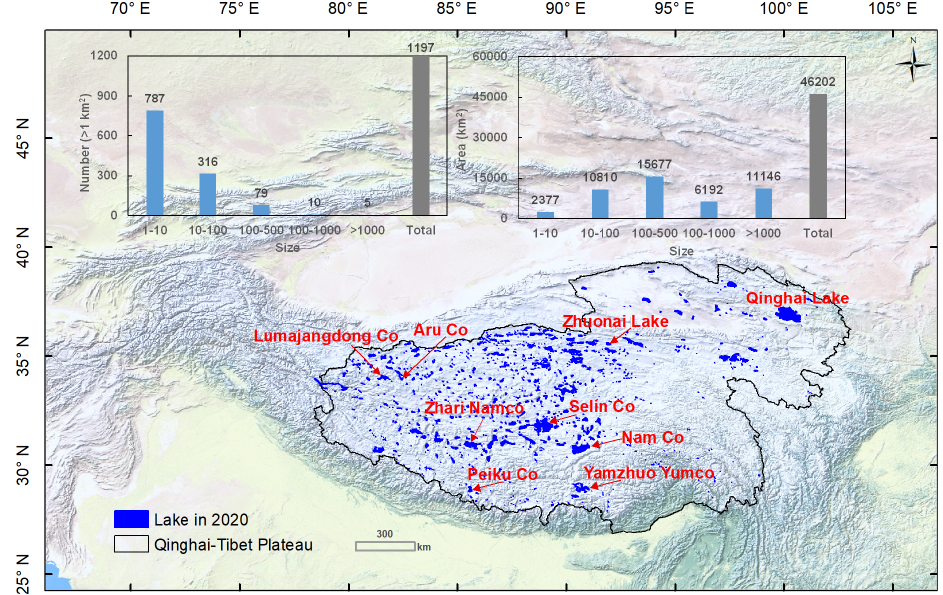
Figure 1. Distribution of lakes over the QTP. Insets show, for lakes larger than 1km 2 , the number and area of lakes in different size ranges and the total number and area (status: 2020). The names refer to the lakes presented as examples in Fig. 7. The background of this figure is from Natural Earth at https://www.naturalearthdata.com (last access: 20 December 2020).